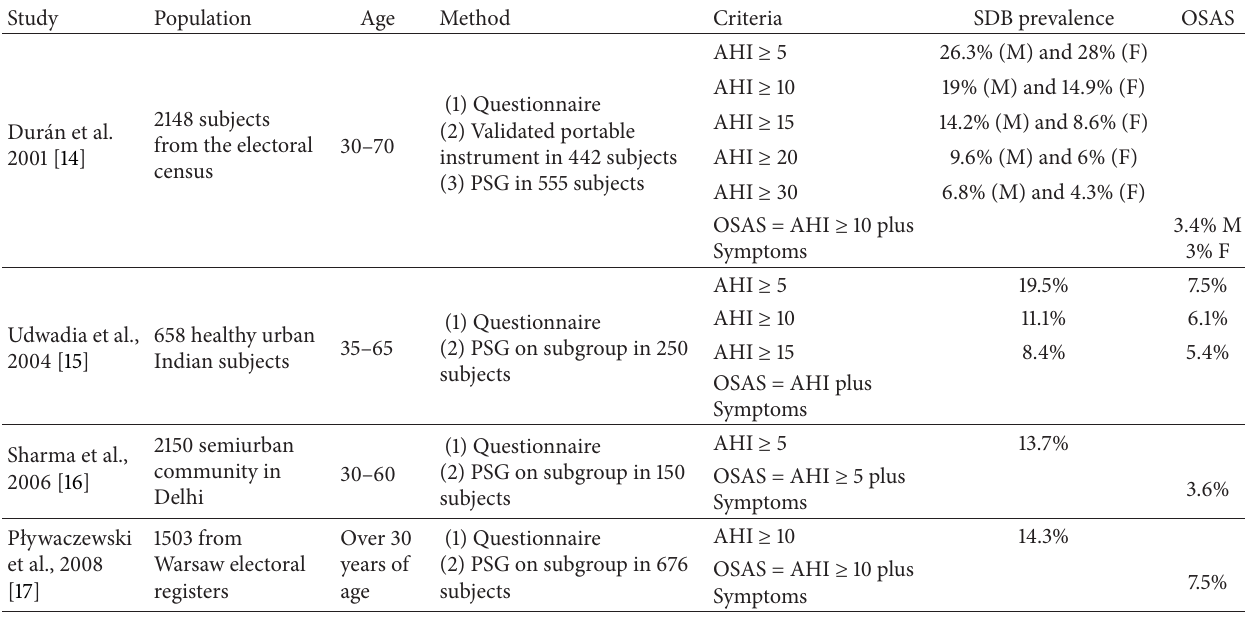
Table 1: Prevalence studies on obstructive sleep apnea